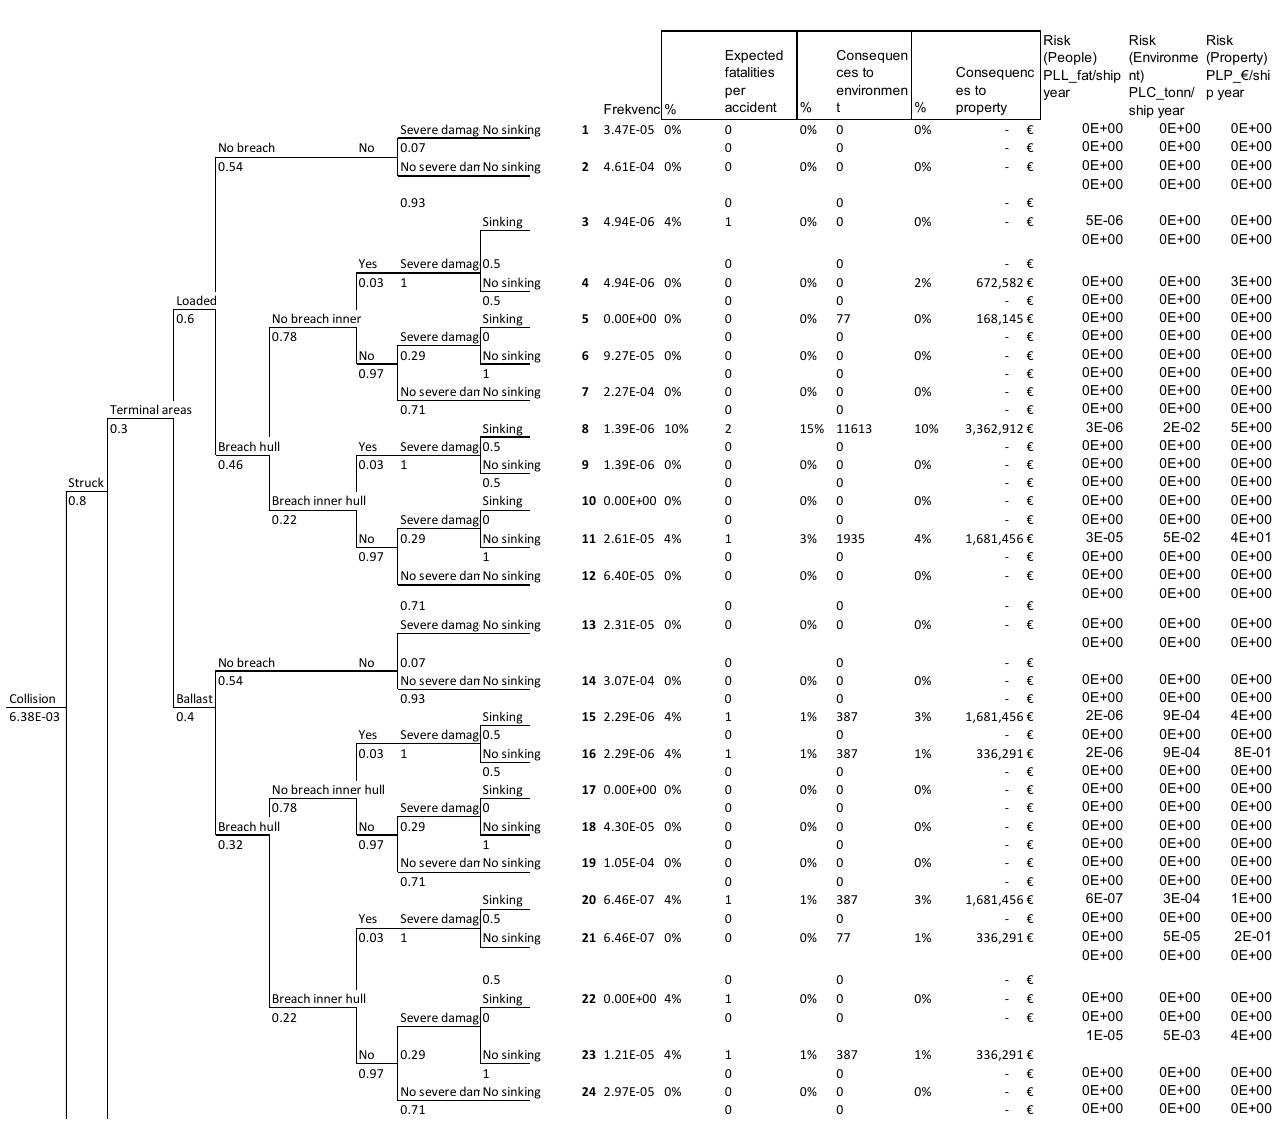
Figure 6. Event tree for ship collision.